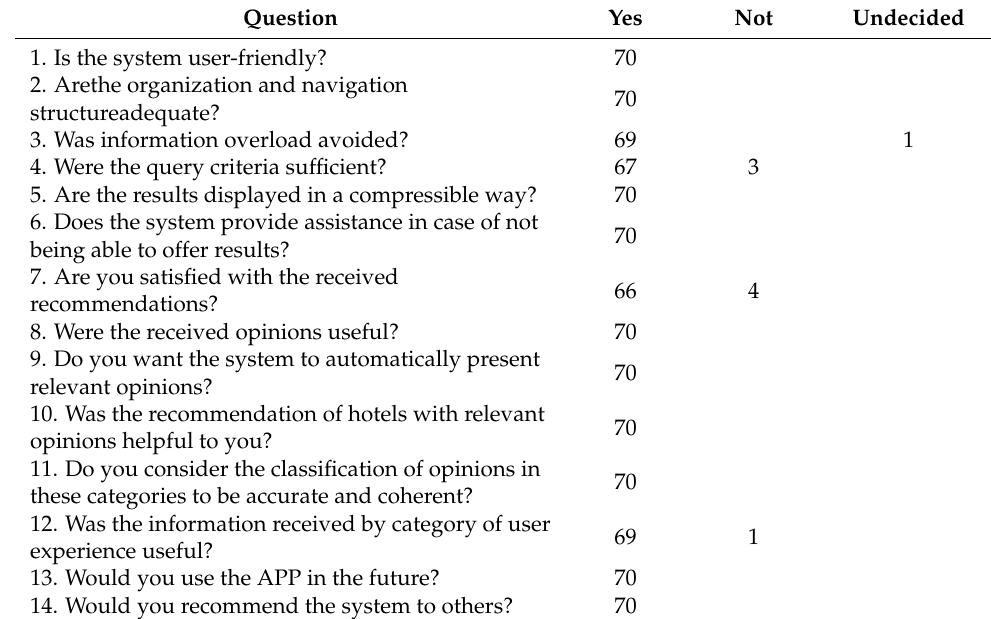
Table 5. Questionnaire and results of the validation using the TAM